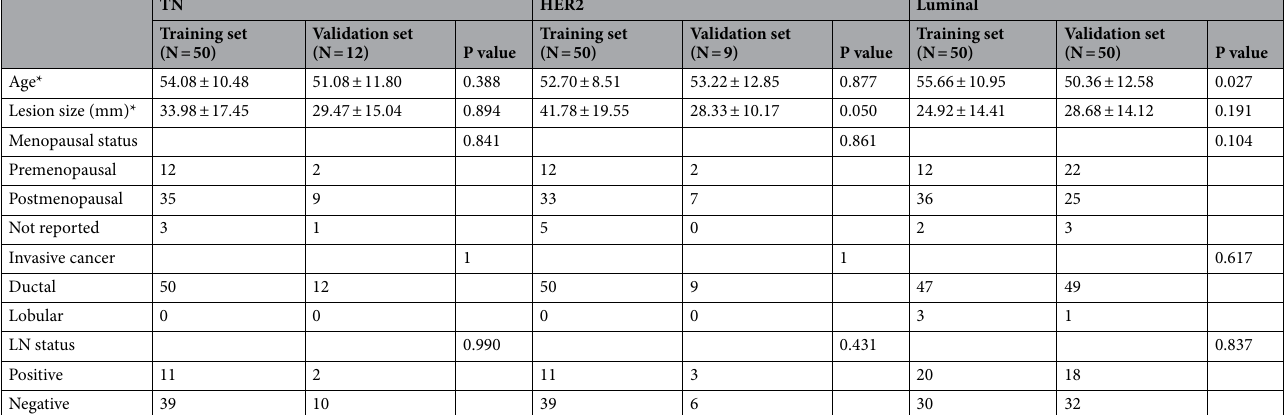
Table 1. Characteristics of patients and lesions. TN triple-negative, LN lymph node. * Data are means ± standard deviations.